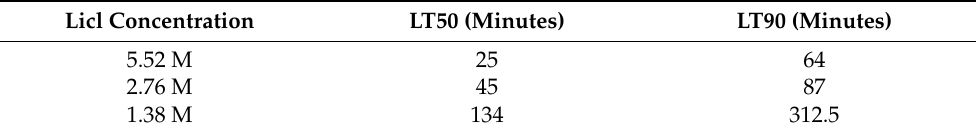
Figure 3. Concentration-response curve and LD50 concentration value for lithium chloride in poultry red mite. Note that LD50 value was calculated based on the net effect of the tested substance (i.e., mortality above the control level).